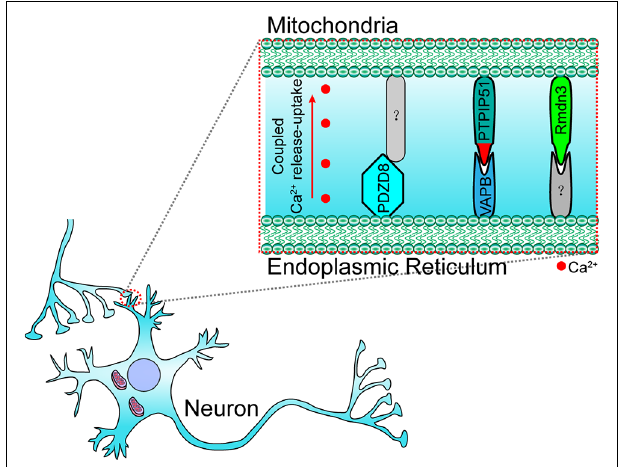
FIGURE 3 | Paradigm of molecular determinants in ER-mitochondria tethering in the dendrite of neurons. In the dendrite, VAPB (located at ER) interacts with PTPIP51 (located at OMM) to maintain ER–mitochondria tethering and synaptic activity-coupled Ca 2+ release-uptake. PDZD8 (located at ER) and Rmdn3 (located at OMM) are also involved in synaptic activity-coupled Ca 2+ release-uptake and ER-mitochondria membrane contact. However, their interacting partners have still not been identified. VAPB, vesicle-associated membrane protein-associated protein B; PDZD8, PDZ domain-containing protein 8; Rmdn3, regulator of microtubule dynamics protein 3.